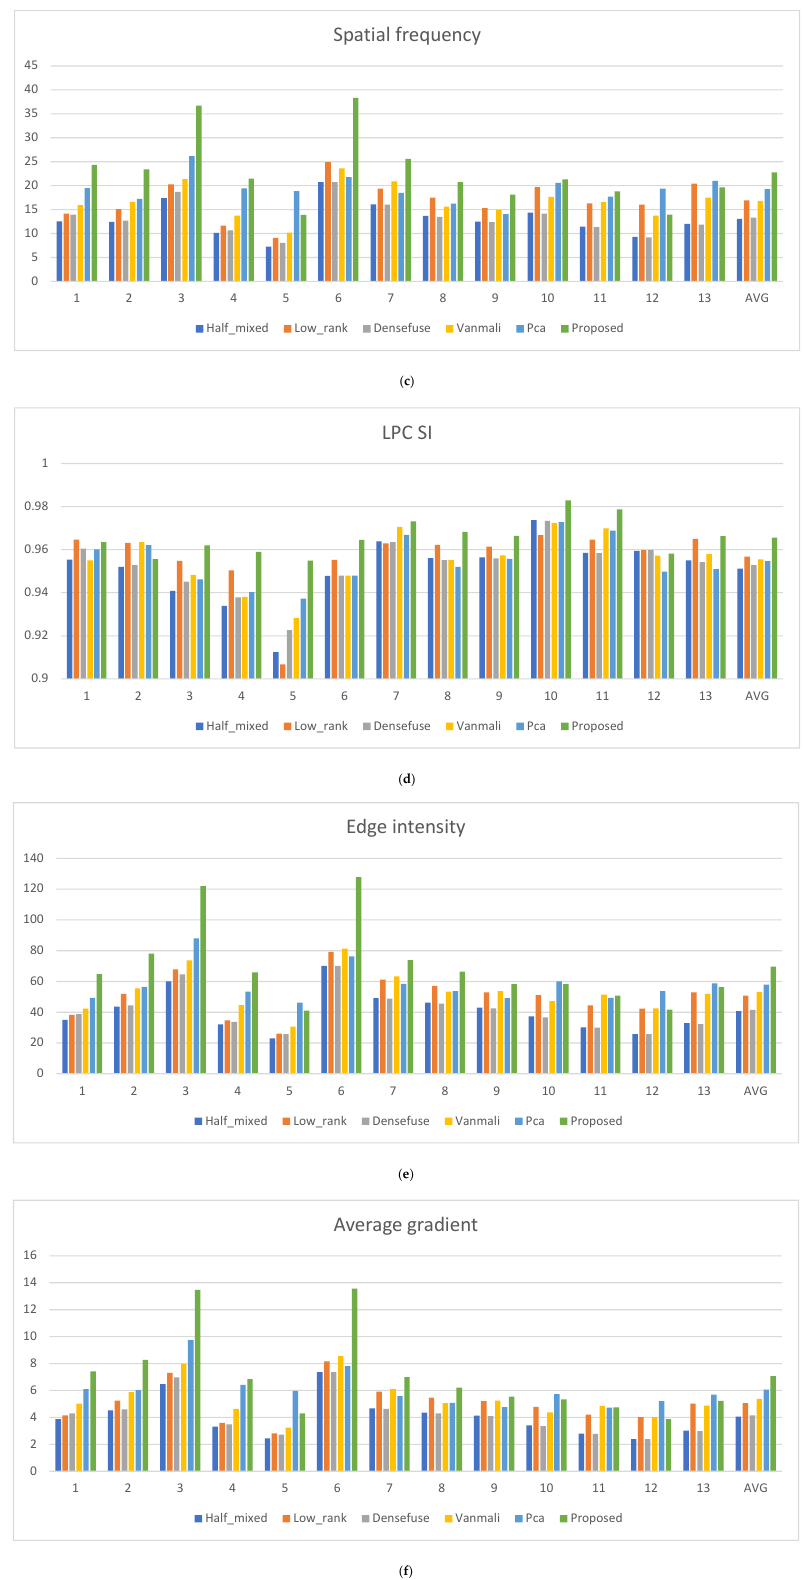
Figure 20. Metric scores: ( a ) S3 score; ( b ) VIFF score; ( c ) spatial frequency score ( d ) LPC SI score; ( e ) edge intensity score; ( f ) average gradient score.